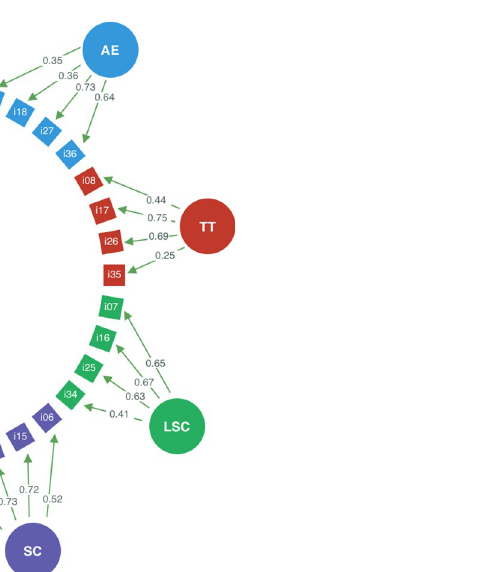
Table 3 details the matrix of factor covariances found in the nine multi-correlated model.